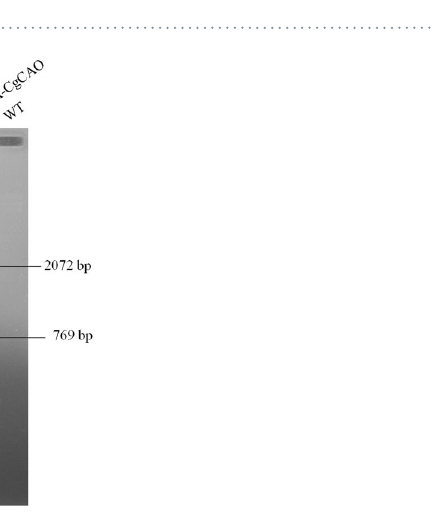
Figure 5. Construction of plasmids overexpressing CgLDC and CgCAO . ( A ) CgLDC was cloned into the pGB92 vector with trpC promoter between restriction sites SacI and BstEI to obtain the recombinant plasmid pGB92- CgLDC. ( B ) The Gibson method was used to construct the recombinant plasmid pGB92-CgCAO. ( C ) The gpdA, alcA, olic, and agdA promoters were ligated into the recombinant plasmid pGB92-CgLDC to produce pGB93-CgLDC, pGB94-CgLDC, pGB95-CgLDC, and pGB96-CgLDC. ( D ) The gpdA, alcA, olic, and agdA promoters were ligated into the recombinant plasmid pGB92-CgCAO to produce pGB93-CgCAO, pGB94- CgCAO, pGB95-CgCAO, and pGB96-CgCAO.